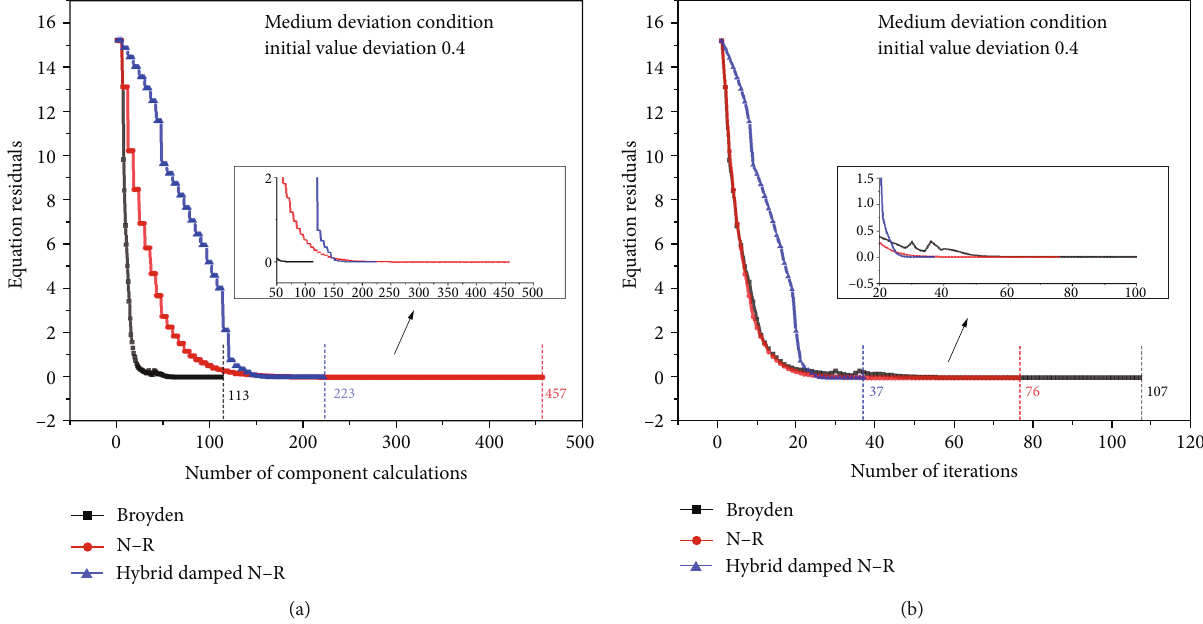
Figure 4: The variation of residuals with the number of model calculations and iteration steps under the initial deviation of